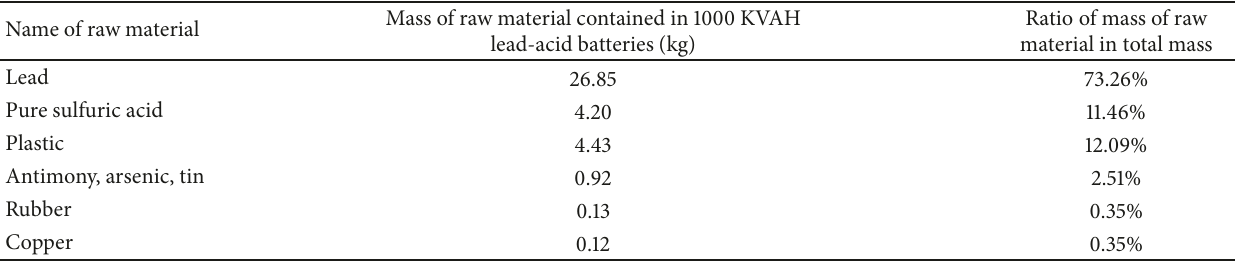
Table 13: List of raw materials of lead-acid batteries (Yu Y. J. et al. 2010 [21]; Zhang H. et al. 2013 [22]). Name of raw material